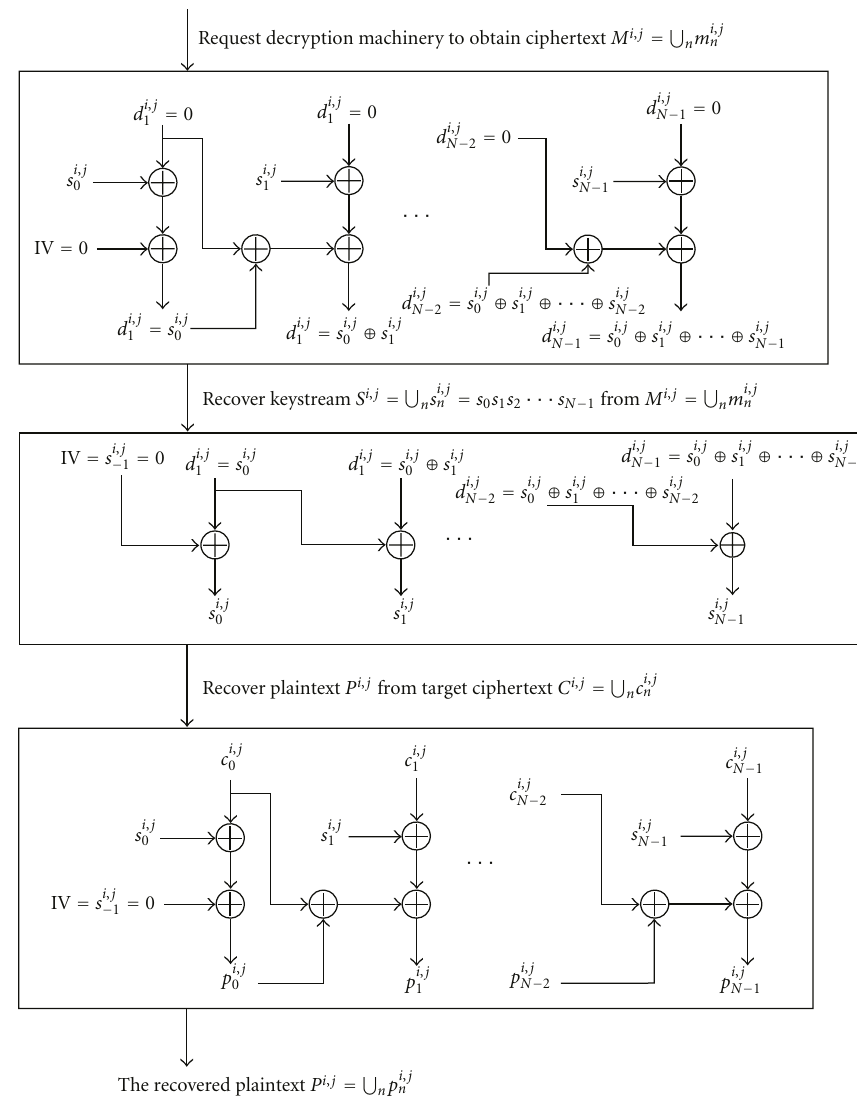
Figure 4: Flowchart of chosen-ciphertext attack